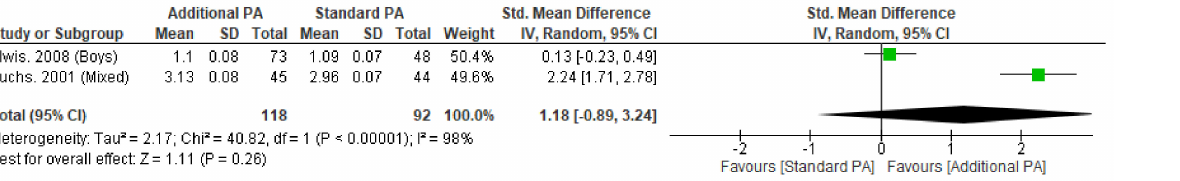
Figure A1. Effect of Additional Exercise Interventions on Femoral Neck Cross-Sectional Area at Less than 15 Months Follow-up. Legend: PA = Physical Activity, Std = standardised, IV = inverse variance, SD- standard deviation, CI = confidence